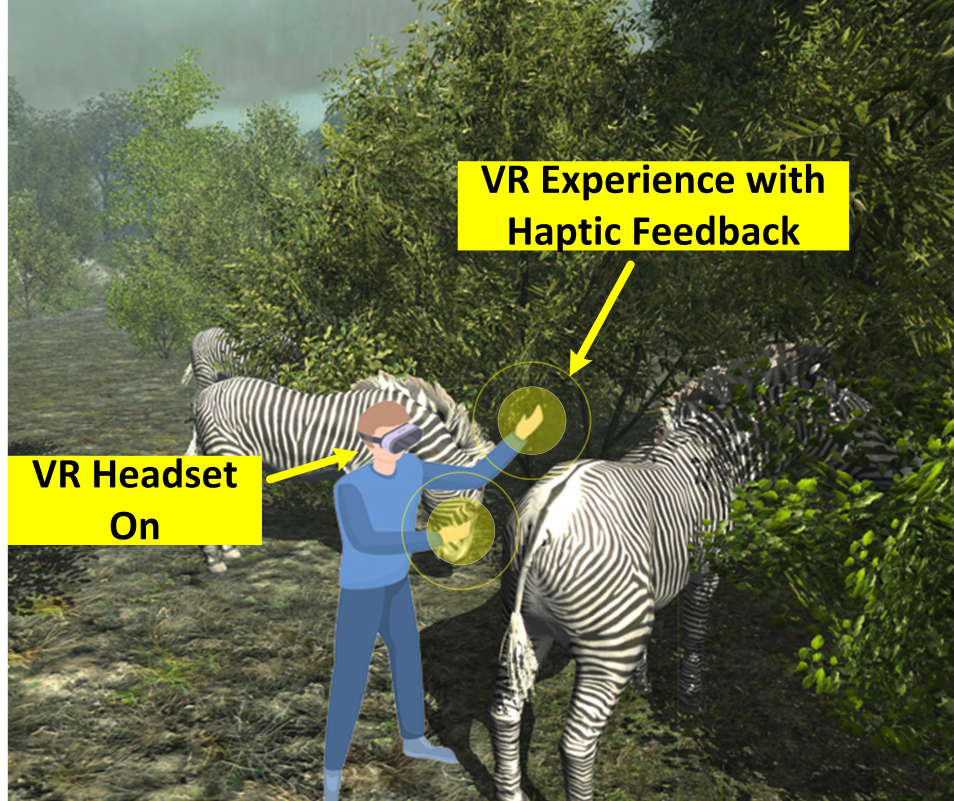
Figure 7. The user experiencing virtual reality of touching the wild